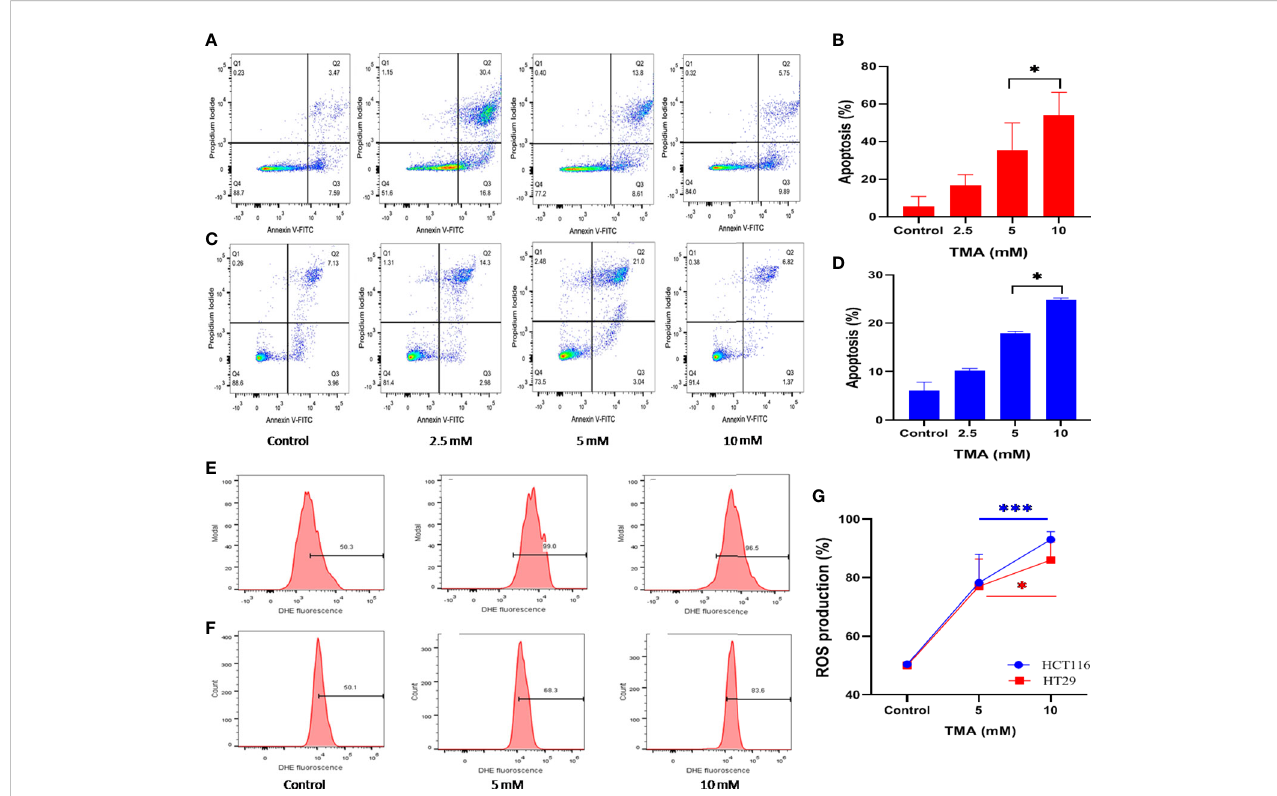
FIGURE 2 Detectionof apoptosis and oxidative stress induced by superoxide radicals. EffectofTMA onHCT116 (A, E) , HT29 (B, F) cells was checked by fl ow cytometry. (A – C) arerepresentative fl ow cytometric dot plot showing the percentage ofviable cells (annexin V-FITC-, PI-),early apoptotic cells (annexin V-FITC+, PI-),late apoptotic cells (annexin V-FITC+, PI+)and necrotic cells (annexin V-FITC-, PI+).Results areplotted as no. of apoptotic cells (annexin V-FITC+, PI-) which shows signi fi cant increase in apoptosis with increase in concentration ofTMA (B, D) . Negative control cells weretreated withsolvent only. TMA induces productionof anionsuperoxide radical in both cell lines, (E) . HCT116 and (F) . HT29.HCT116 and HT29 cells weretreated with5 mM and 10mMTMA for 48 h. Difference of averagevalues betweenuntreated and treated cells weretested using paired student ’ s t-test.Both cell lines showedsigni fi cant increase in apoptosis and ROS productionparticularly 10mMTMA proved most toxic to cells. The exposureof TMAled to an increase in fl uorescence intensity in both cell lines thereby, shifting histogram towards right (G) . The results (mean±SEM) wereobtained from3 independent experiments. *indicates signi fi cantly different values compared to control group ( P <0.05). ***indicates signi fi cantly different values compared to control group ( P